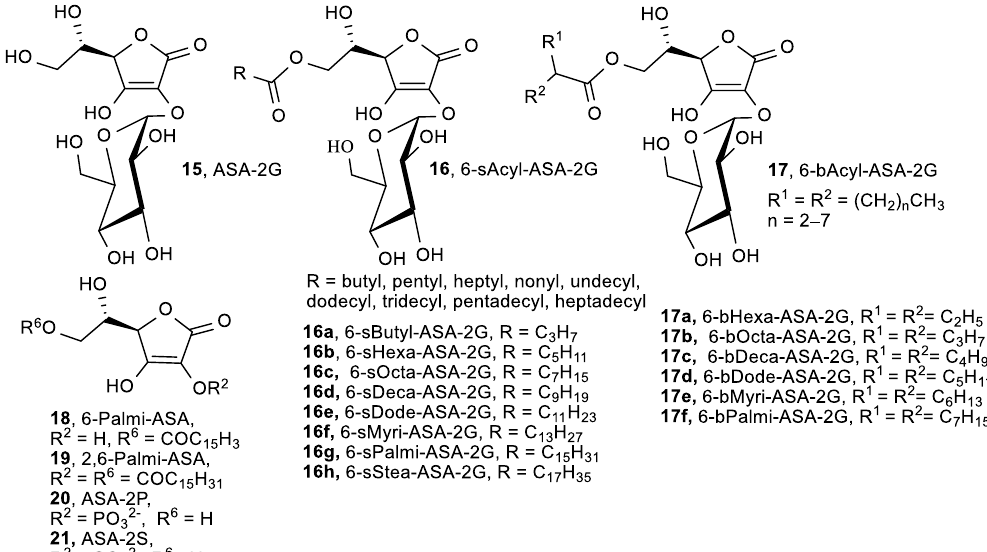
Figure 7. Glucoside ASA derivatives as potential radical scavengers.